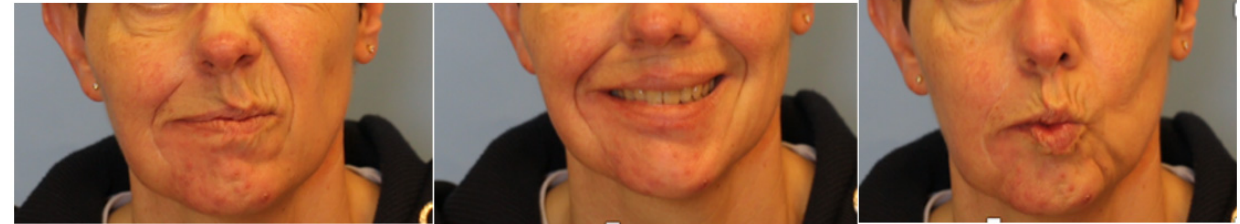
Figure 6. Postoperative result 16 months after the procedure in patient 4. Left: wrinkling the nose; center: smiling; right: pointing the mouth.